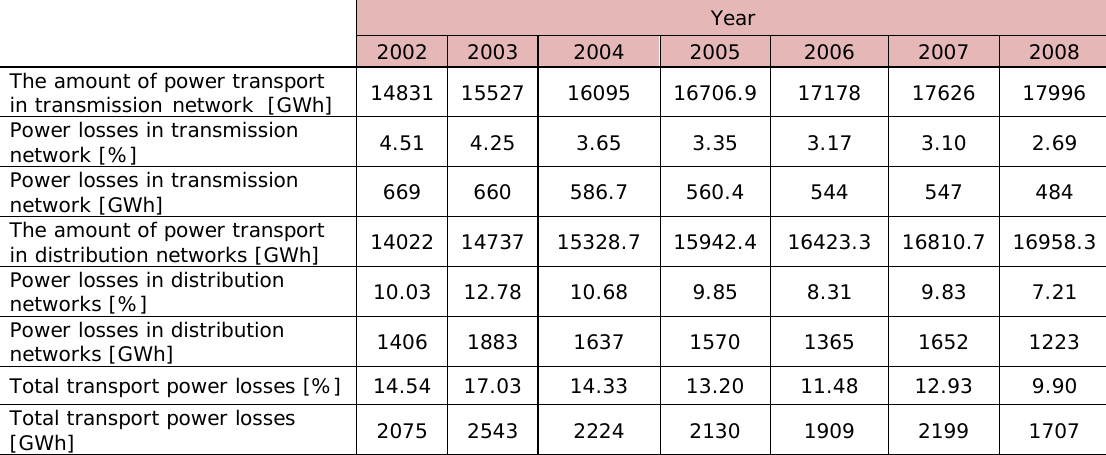
Table 1. “Losses in Croatian power networks”. Source: HEP d.d. annual reports; HEP ODS d.o.o. annual reports; HEP OPS d.o.o. annual